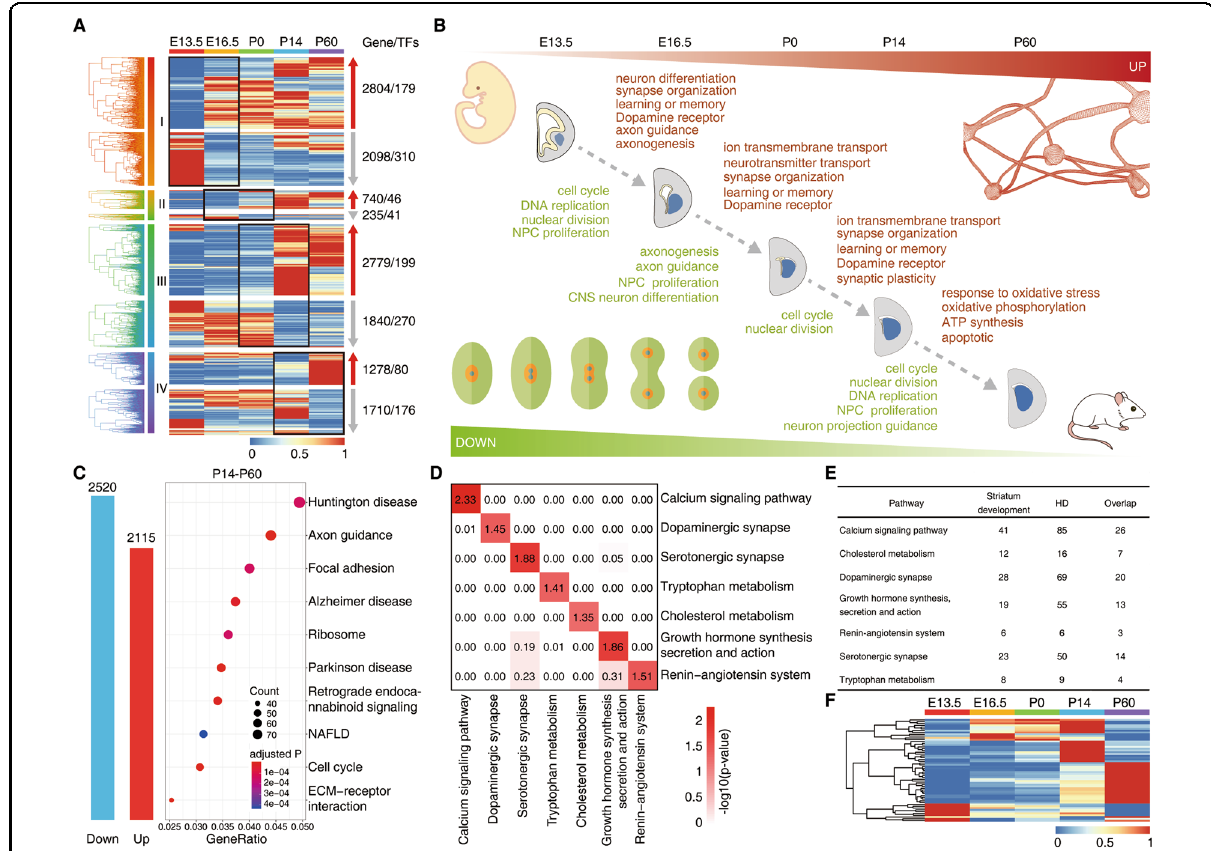
Fig. 2 Striatal development and correlation analysis with HD. A Expression patterns of DEGs between two adjacent time points. The number of genes and TFs are shown on the right. B The patterning of striatal development in mice. C Histogram of DEGs (FDR < 0.05) in the striatum from P14 to P60. The top ten signi fi cant KEGG pathways of these DEGs are displayed. D Two-tailed hypergeometric tests were conducted to determine whether there is a signi fi cant overlap of altered genes on a speci fi c pathway between striatal development and HD. Correlations on seven pathways between striatal development and HD. E The number of signi fi cantly altered and overlapping genes on seven signaling pathways in striatal development and HD. The genes (FDR < 0.05) differentially expressed in striatal development and HD (adjusted P < 0.05). F Temporal expression patterns of 57 overlapping genes across fi ve time